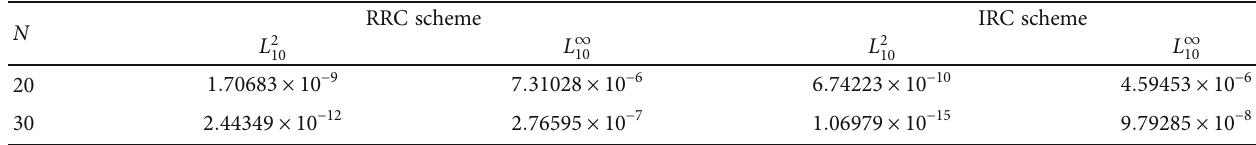
and L ∞ on interval x ∈ ½ 0, 10 (cid:2) for λ = 1 . 10 10